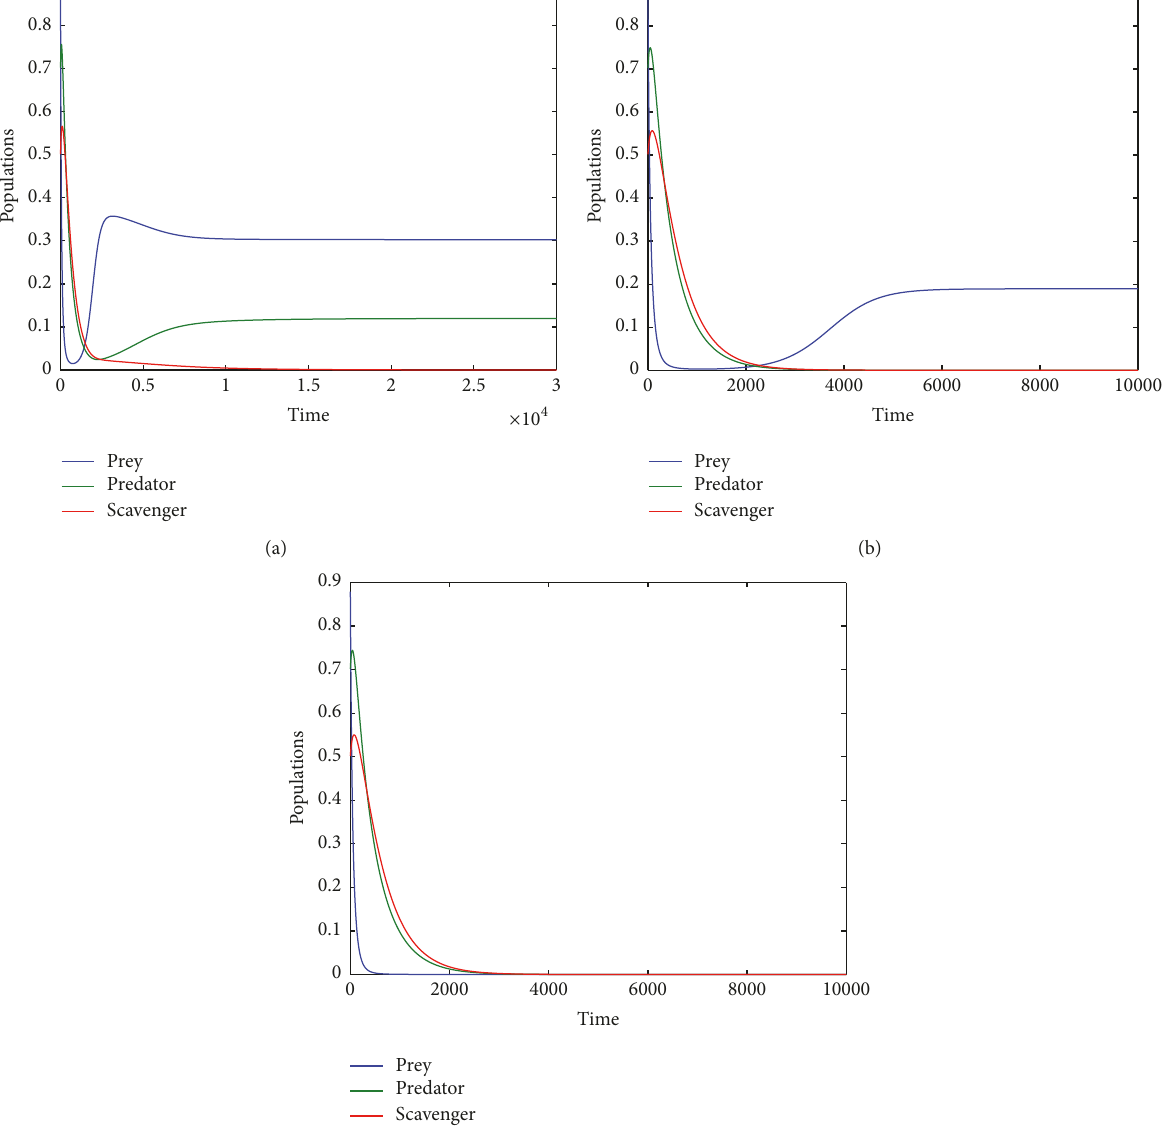
On the other hand, for the parameter data (76) with 𝛿 ≥ 0.23 or 𝜂 ≥ 0.23 the solution of system (3)